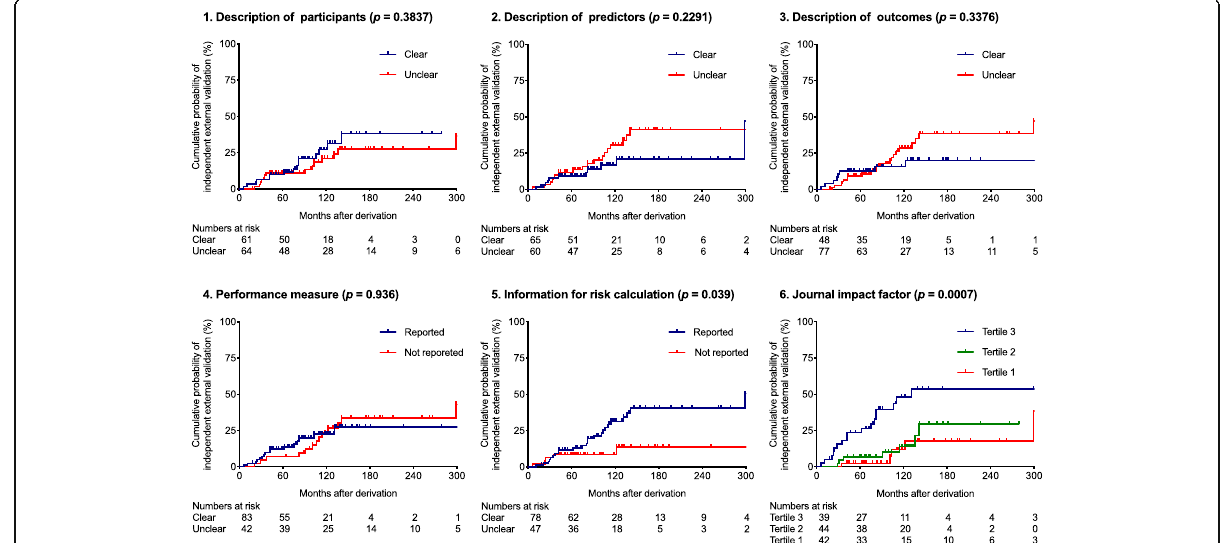
Fig. 4 Kaplan-Meier plot. Probability of an independent external validation for reporting and publication-related predictor